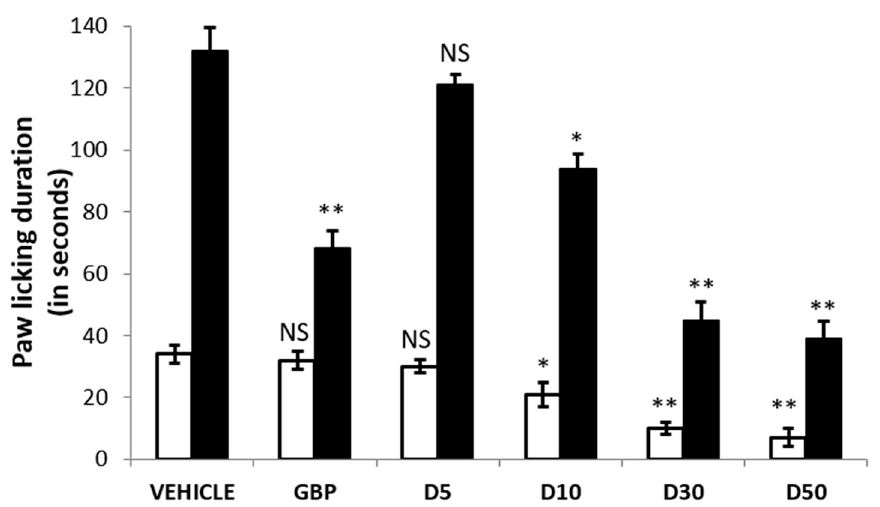
Figure 5. Formalin-induced analgesic test; a dose of the test compound 20 (5, 10, 30, and 50 mg/kg, p.o, suspended in 0.5% CMC) was administered 4 h before formalin injection (50 µL, 2.5%). Reference drug, gabapentin (100 mg/kg, i.p, dissolved in 0.9% normal saline) was injected 30 min before formalin injection. Total paw licking and biting duration, Stage I (white bar, 0–5 min) and stage II (black bar, 10–30 min) was recorded as a measure of pain behavior. Data is represented as mean ± SEM from a group of 10 animals. * p < 0.05, ** p < 0.01, p > 0.05 (NS, nonsignificant) vs. control (ve-